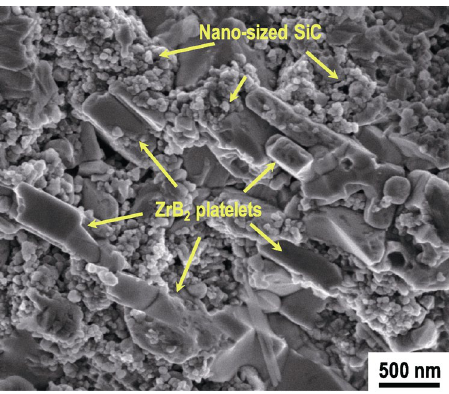
Fig. 6 SEM image of the sample RZSZ-15 on the fracture surface.